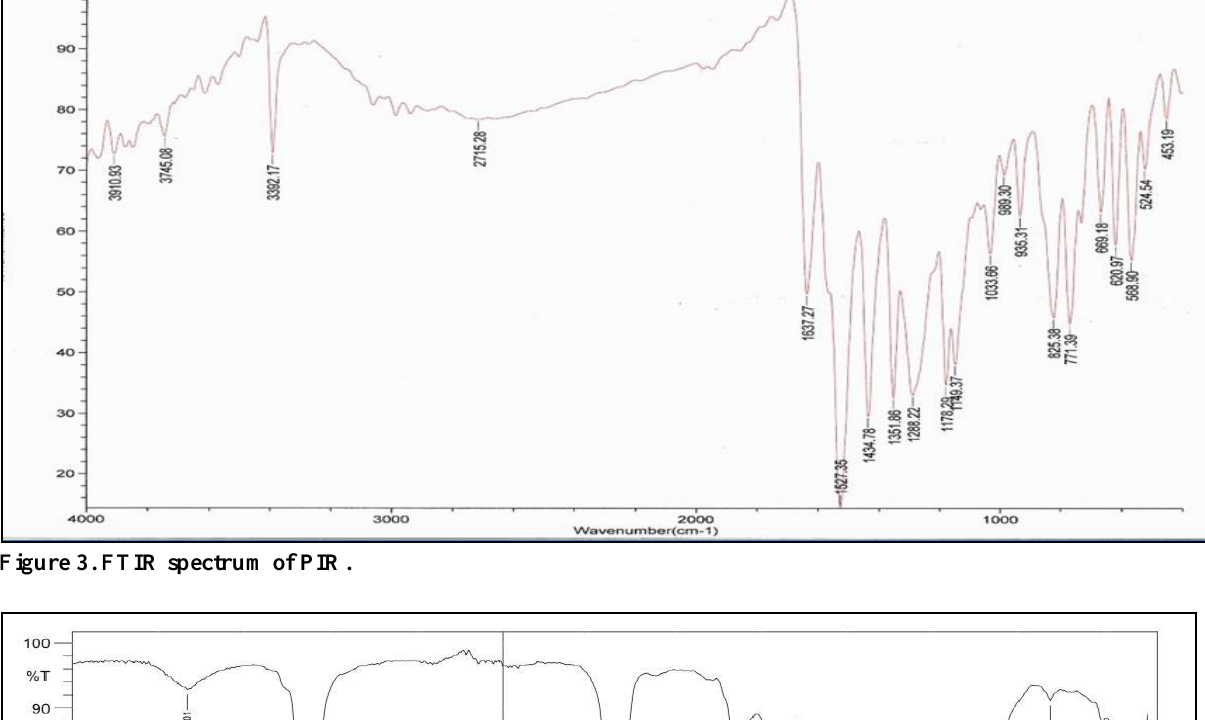
Figure 3. FTIR spectrum of PIR.